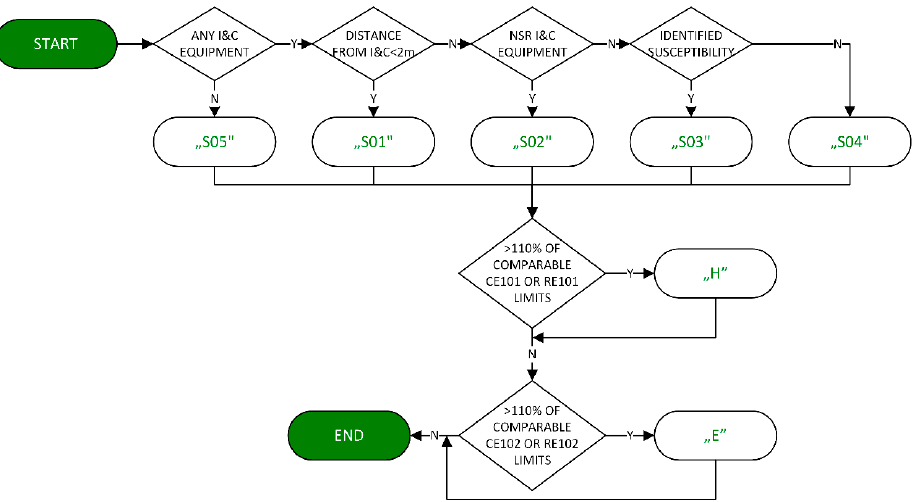
Figure 2. Flowchart assigning the susceptibility and emission attributes.